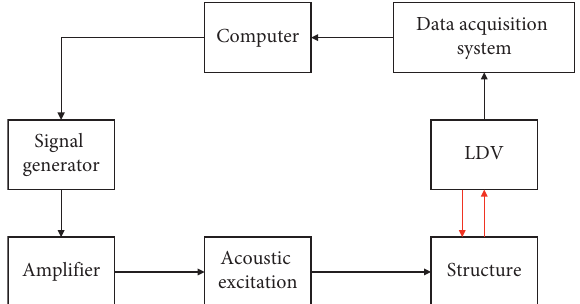
Figure 1: Configuration of the multiblade packet measurement